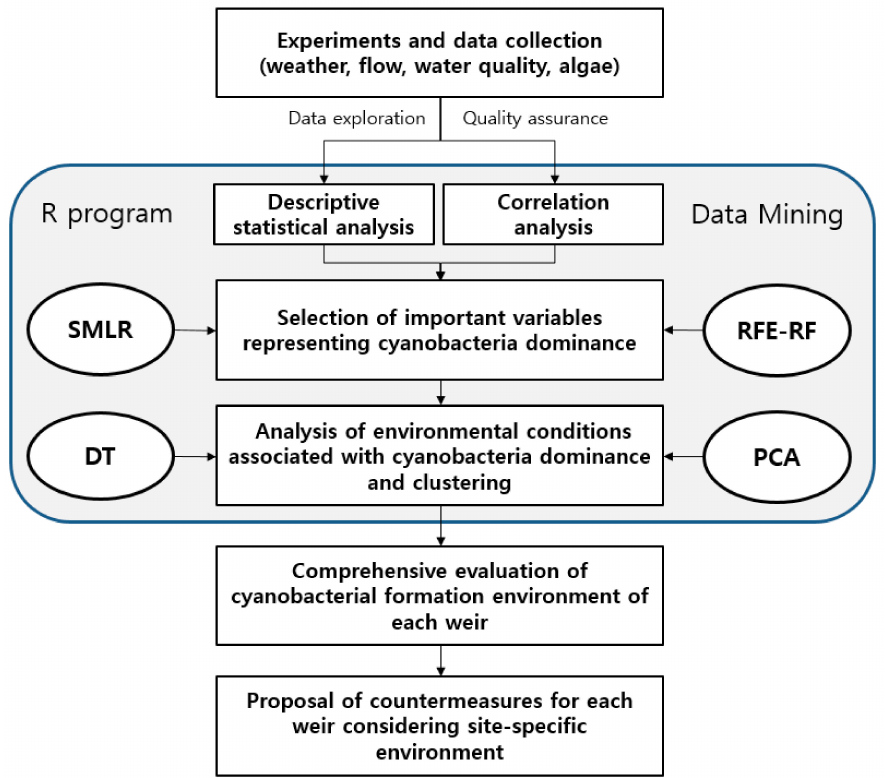
Figure 2. Flowchart of statistical analyses and data mining processes employed in this study. SMLR - step-wise multiple linear regression, RFE-RF - recursive feature elimination using random forest models, DT- decision tree, PCA – principle component